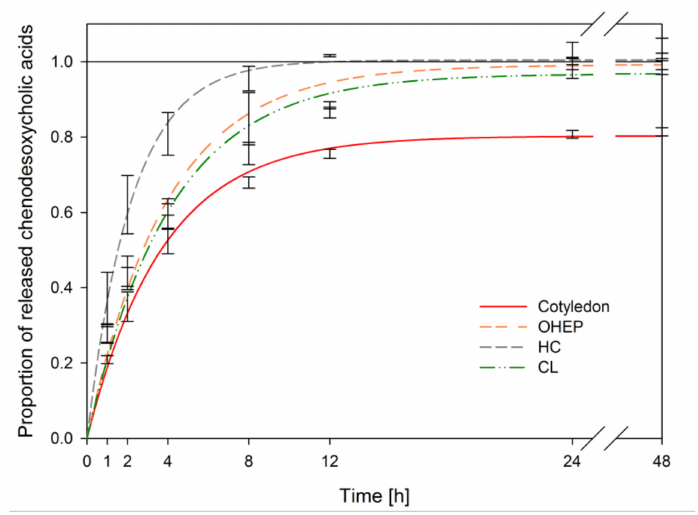
Figure 7. Release kinetics of chenodesoxycholic acids of in vitro digested fractionated dietary fibre (pectin-like fraction (OHEP), hemicellulose fraction (HC), cellulose-lignin fraction (CL)) derived from lupin cotyledon of L. angustifoilus L. Boregine ( n =